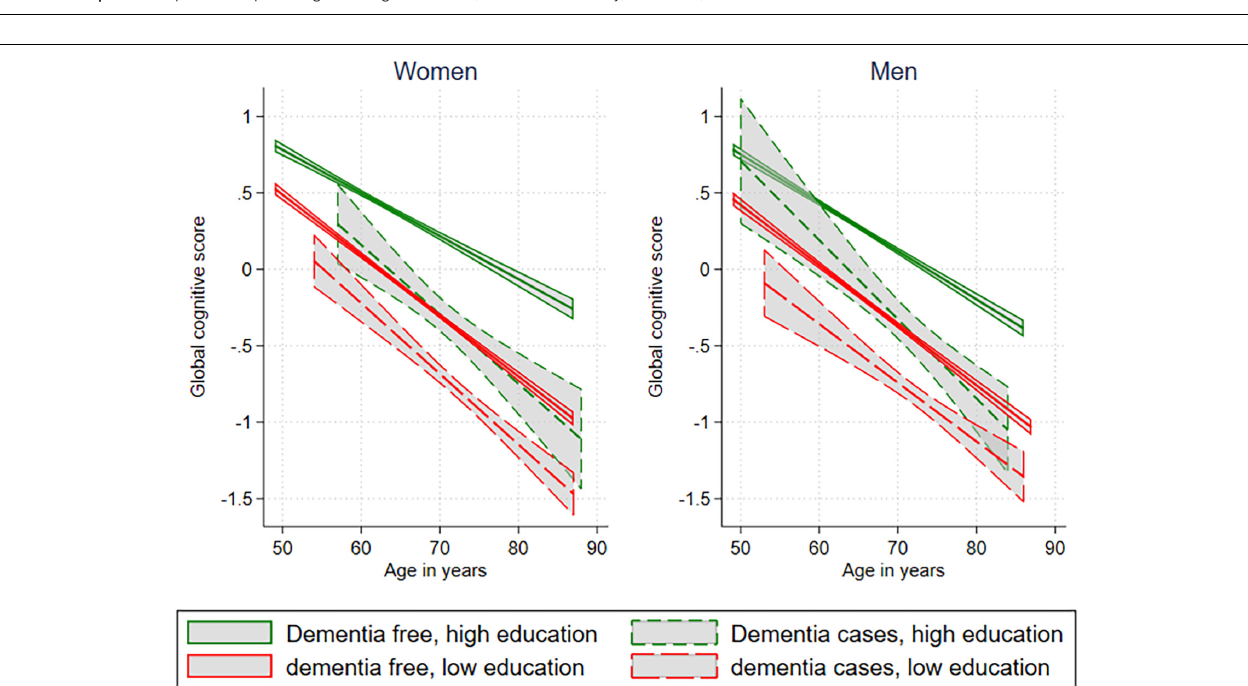
FIGURE 3 | A linear fit prediction plot for global cognitive score on age with a 95% confidence interval of the prediction, stratified on sex and education level. Only adjusted for age.